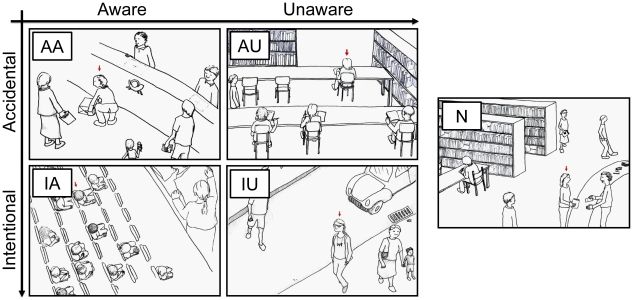
Examples of the stimulus material applied in the fMRI study.Drawn sketches depict a protagonist, indicated by the red arrow above his/her head, in possibly embarrassing situations. During the fMRI experiment each sketch was accompanied by a sentence introducing the current scenario. Situations were presented with the following textual vignettes for clarification: AA: You are at a post-office: the trousers of a person in front of you rip as he bends down to lift a package…; AU: You are in a library: the person in front of you wears her pants in a way that you can see her slip…; IA: You are at a cinema: during the movie a person in the front row is talking on his mobile…; IU: You are in a pedestrian zone: a young man wearing a VIP-necklet passes by…; N: You are in a library: a woman is borrowing a book at the reception desk…